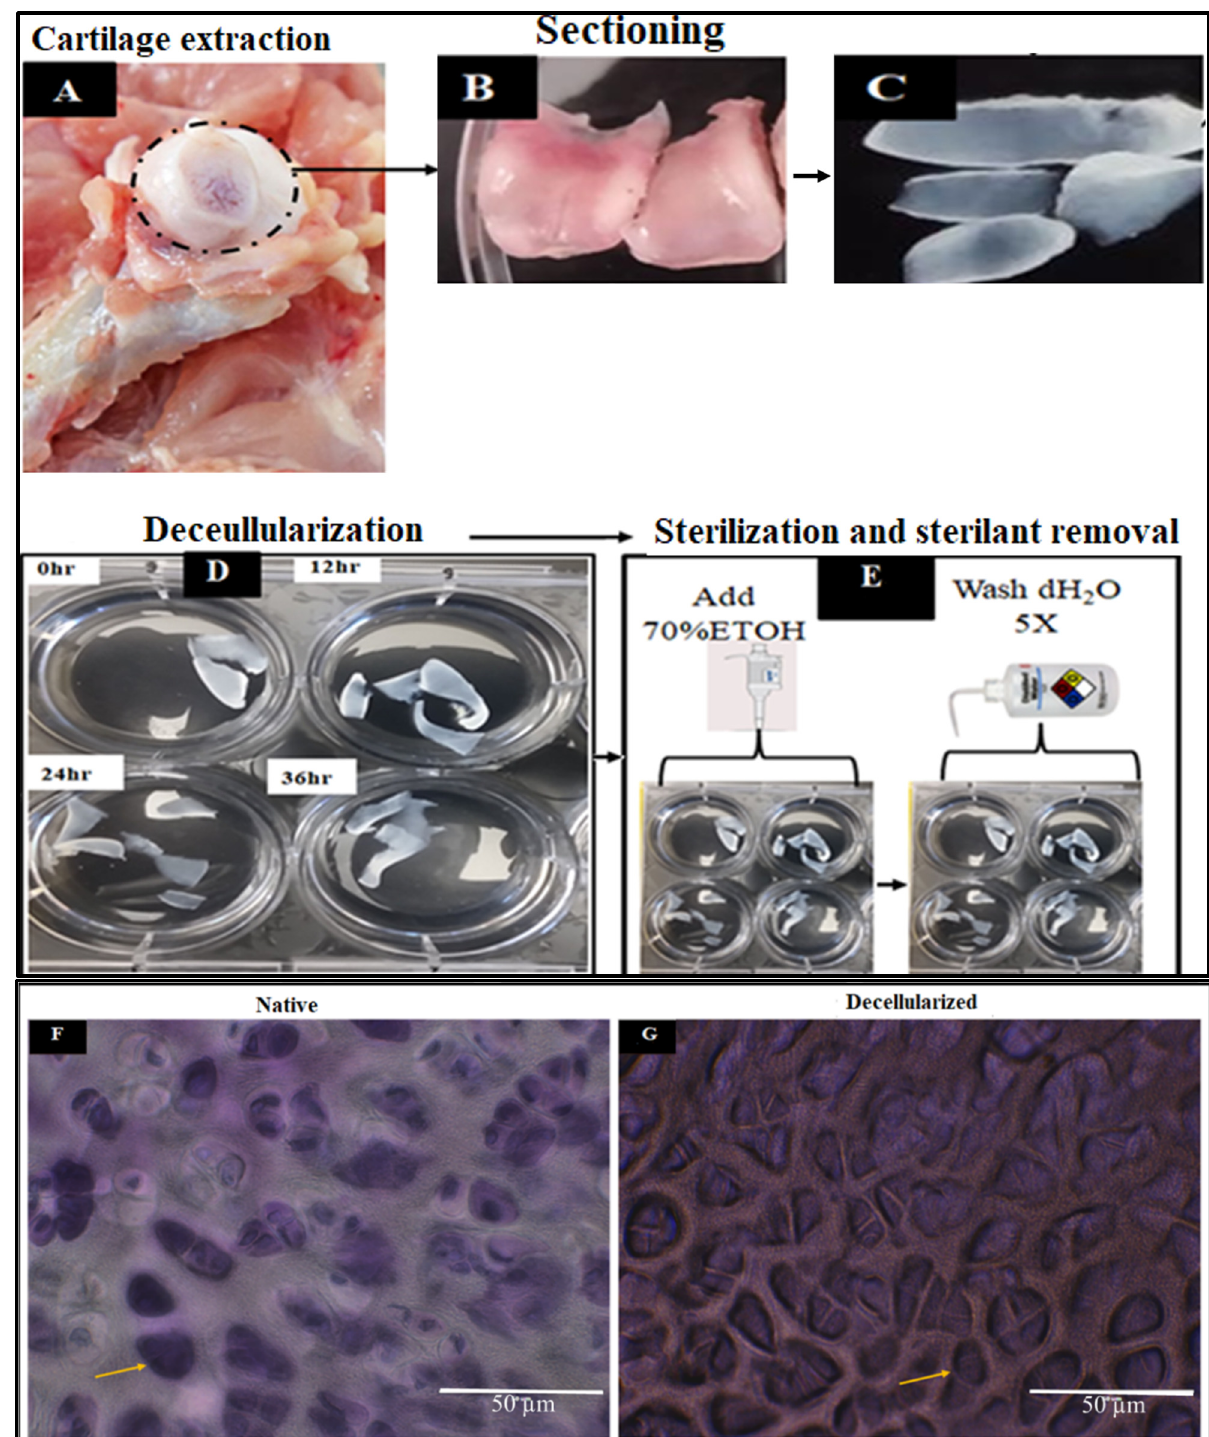
Figure 1. Panels showing the extraction, decellularization, and sterilization process of avian articular cartilage. ( A ) Avian articular cartilage at the knee joint. ( B ) Avian cartilage extracted and photographed. ( C ) Sectioned cartilage before decellularization. ( D ) Decellularization of sectioned samples. ( E ) Sterilization of sectioned and decellularized samples. ( F ) Flash Blue staining of sectioned cartilage revealing the cells’ nuclei in dark blue colors. ( G ) Flash Blue staining of decellularized cartilage revealed the absence of tissue cells/nuclei, showing empty pores.